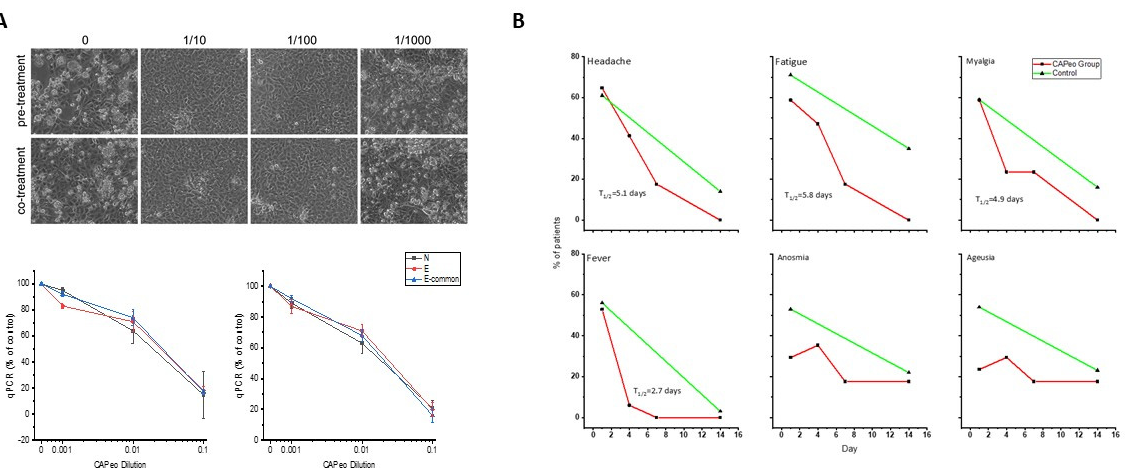
Figure 2. Effect of a mixture of three aromatic plants ((thyme, Greek sage, and Cretan dittany) in SARS-CoV-2 infection. ( A ). In vitro testing. Left panel: light microscopy photographs of CPE in control (0, DMSO) and SARS-CoV-2–infected Vero cells (strain B.1, 0.1 m.o.i), pretreated or cotreated with different concentrations of CAPeo, in DMSO. Lower panel: Curves representing relative abundance (% of untreated control) of SARS-CoV-2 RNA after pretreatment (left curves) or cotreatment (right curves) with different concentrations of CAPeo, using real-time quantitative RT-PCR, targeting N and E regions of SARS-CoV-2 genome and E-common region shared by SARS-CoV and SARS-CoV-2 viruses. Values are shown as mean ± SD of three separate measurements. No significant differences in pretreated or cotreated cells were found. In both cases, CAPeo was efficient in concentrations almost 100 times lower than those administered per os and compatible with the estimated circulating concentration of the product. ( B ). Evolution of selected symptoms in our CAPeo-treated group (red curves), in a proof-of-principle trial (NCT04705753). T 1/2 for the resolution of symptoms was calculated with a logistic regression fit. For comparison, the frequency of symptoms in the reference populations is also presented (green curves).